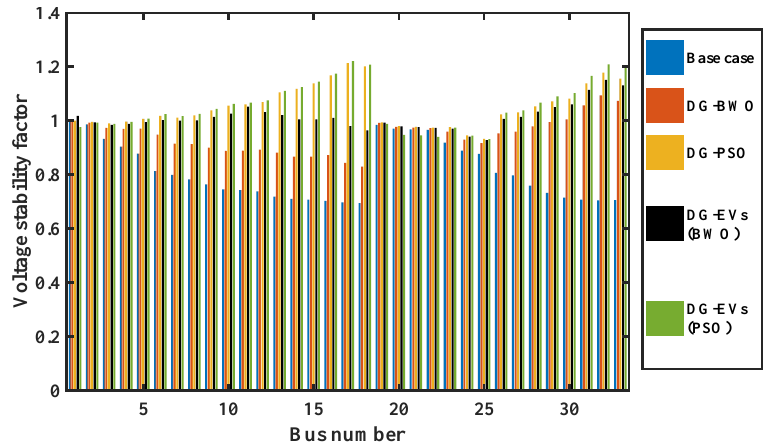
Figure 9. Voltage stability factors at 33 buses of modified test system using BWO and PSO.